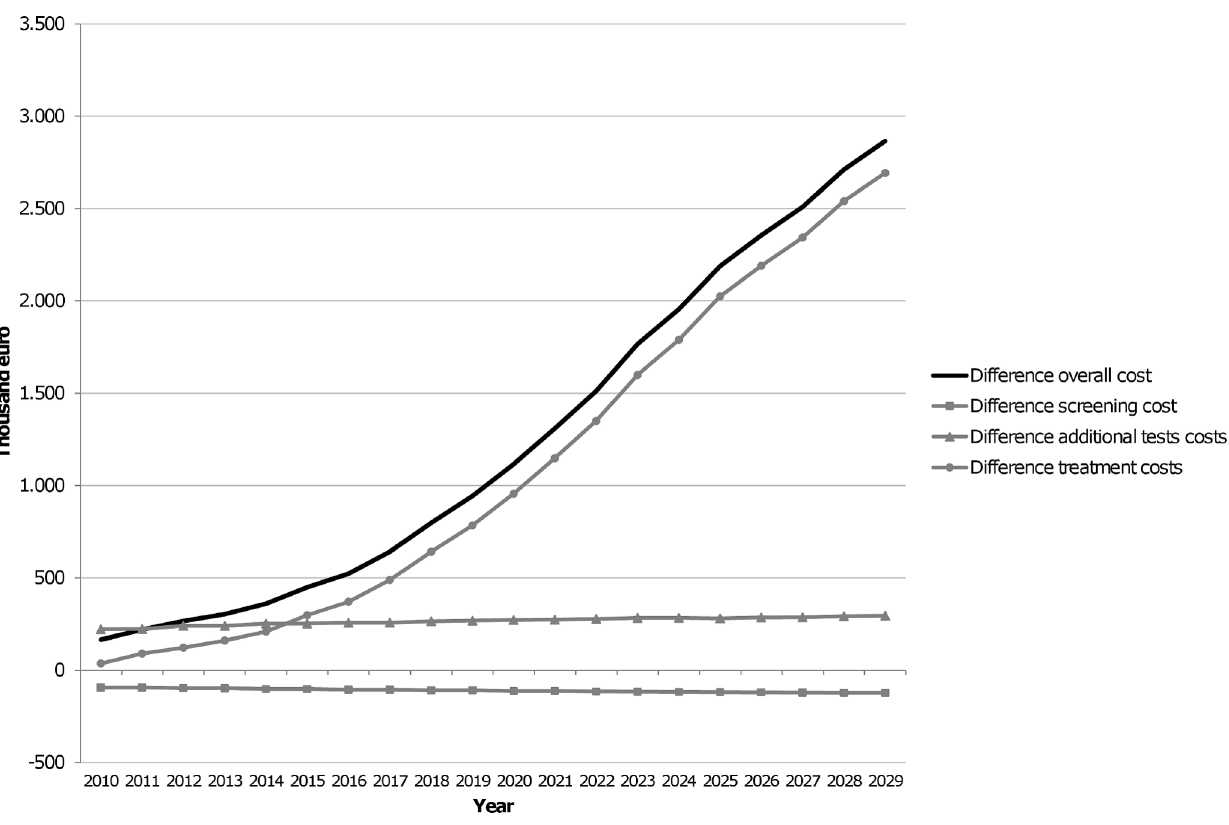
Figure 2. Budget impact analysis. Differences in cost between screen-film and digital mammography, by type of cost and year. Positive differences indicate cost savings with digital mammography.